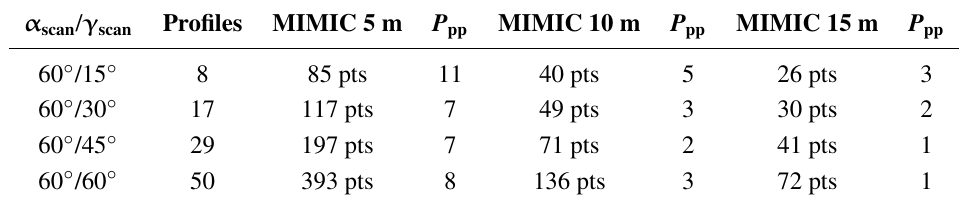
Table 6. The importance of vertical scanner rotations in a dual axis scanner orientation for a narrow vertical 0.1 m × 2 m target at different horizontal ranges. The change in approximate P over range is pp